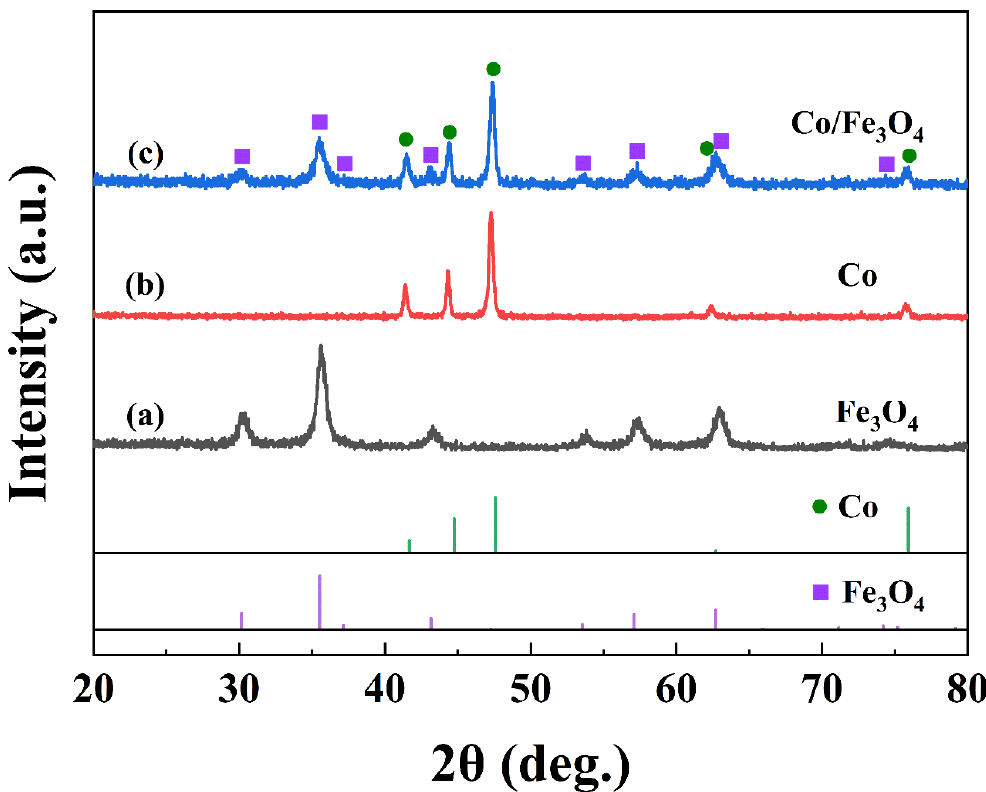
Figure 3. The XRD patterns of Fe 3 O 4 nanoparticles ( a ), Co clusters ( b ), and Co/Fe 3 O 4 composite particles ( c ) with the standard diffraction patterns of hcp-Co and Fe 3 O 4 (JCPDS No. 05-0727, and 88-0315).